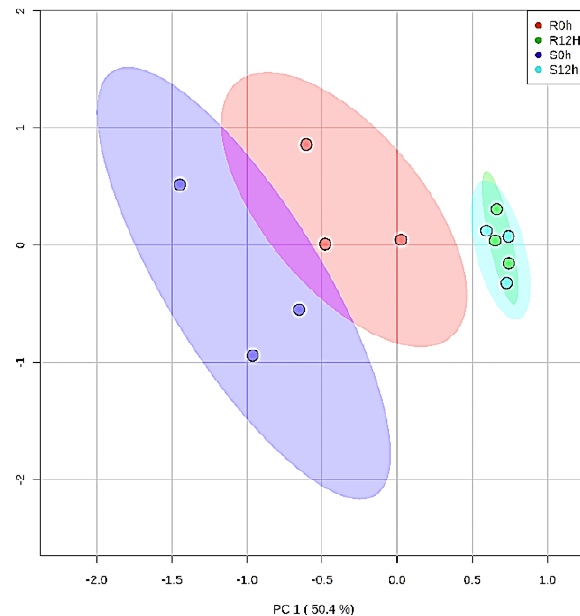
Figure 7. Bi-plot derived from PCA analysis based on susceptible and resistant